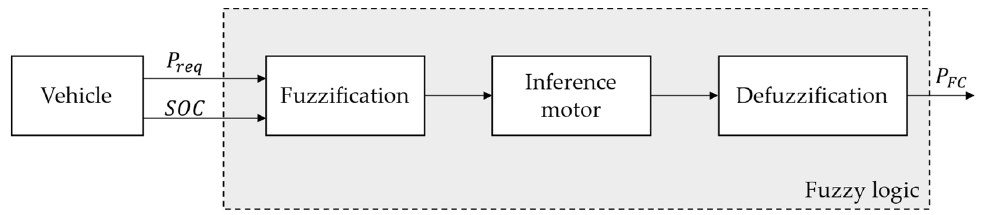
Figure 6. General architecture of the fuzzy logic controller.